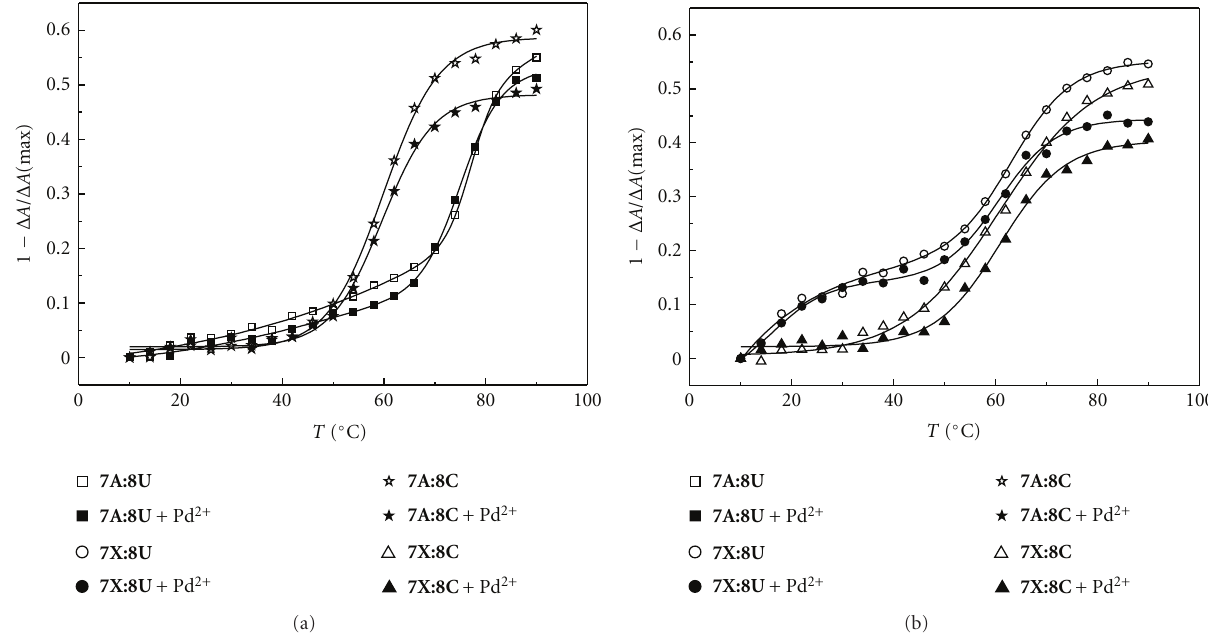
Figure 6: Temperature versus 1 − Δ A / Δ A (max) profiles of the duplexes of the modified ( 7X ) and unmodified ( 7A ) oligonucleotides with the 2 (cid:2) - O -methyl-RNA oligoribonucleotides 8U and 8C in the presence and absence of Pd 2+ ; [oligonucleotides] = 3.0 μ M, [K 2 PdCl 4 ] = 0/3.0 μ M, scan range 220–320 nm; I (NaClO 4 ) = 0.1 molL − 1 ; pH =